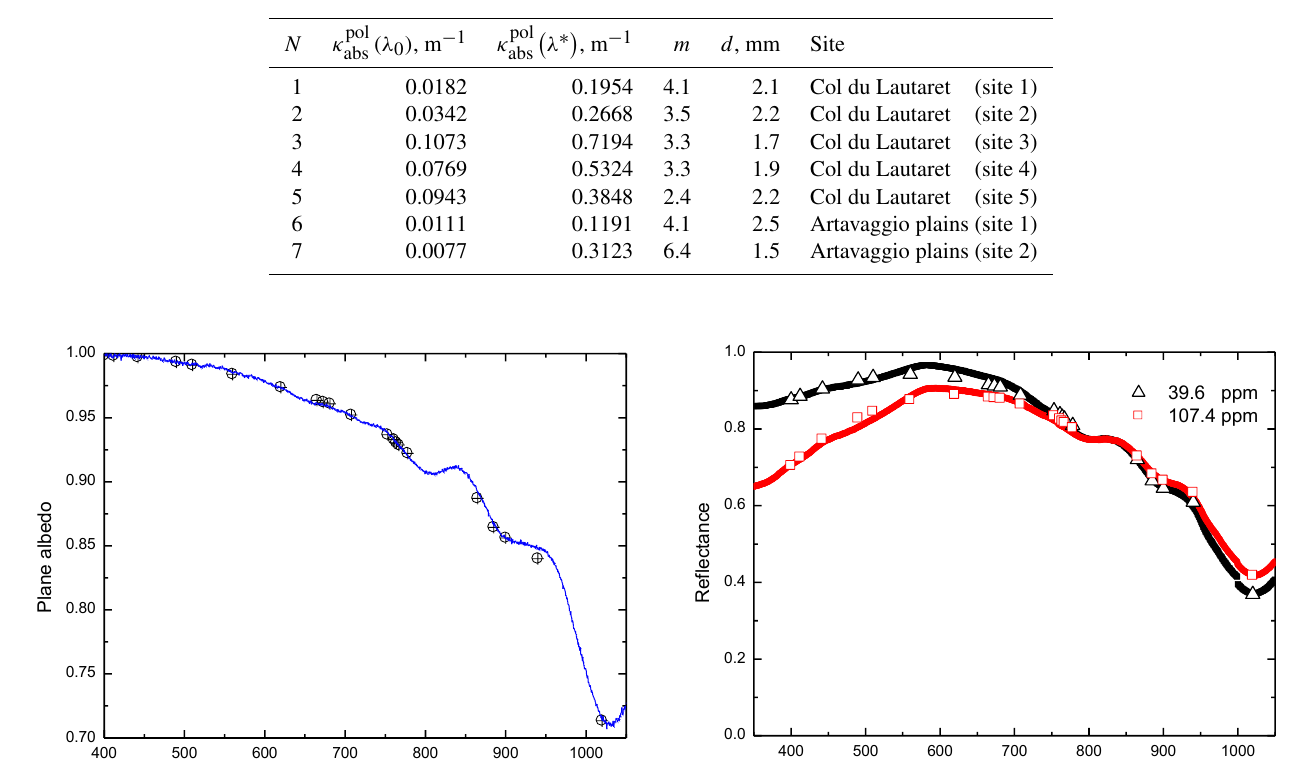
Table 1. The derived snow parameters for the five samples. The value of c is assumed to be equal to 1 / 3, which leads to the extinction length ( l ext = 1 /κ ext ) being equal to the effective grain diameter d . The absorption coefficient is given at the wavelengths λ 0 = 1000nm and λ ∗ = 560nm.